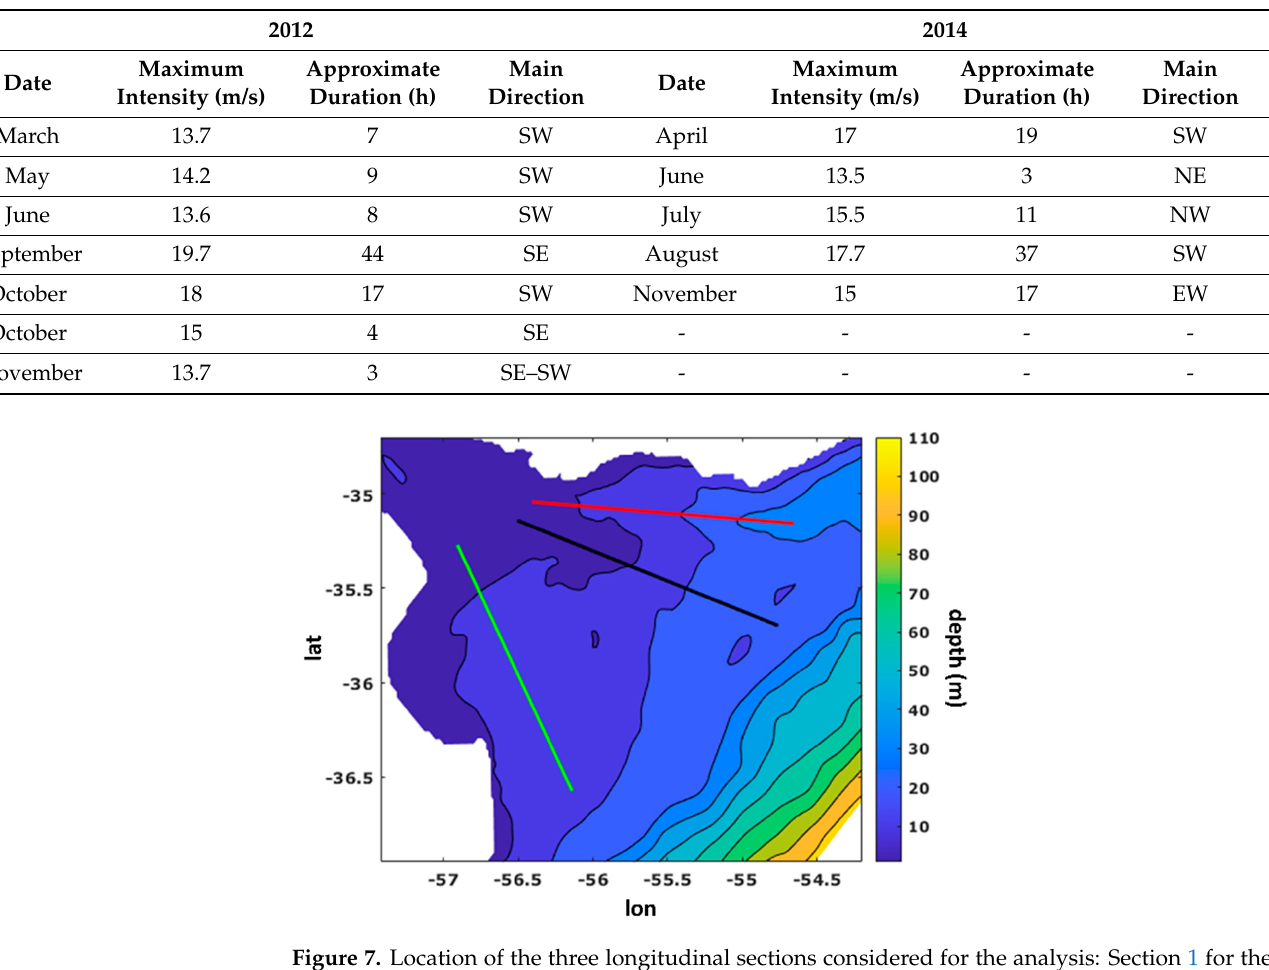
Table 1. Characteristics of the storms identified in 2012 and 2014: maximum intensity (m/s), approximate duration (h), and main direction. Based on ECMWF reanalysis of wind data extracted at the OB location (Figure 1).